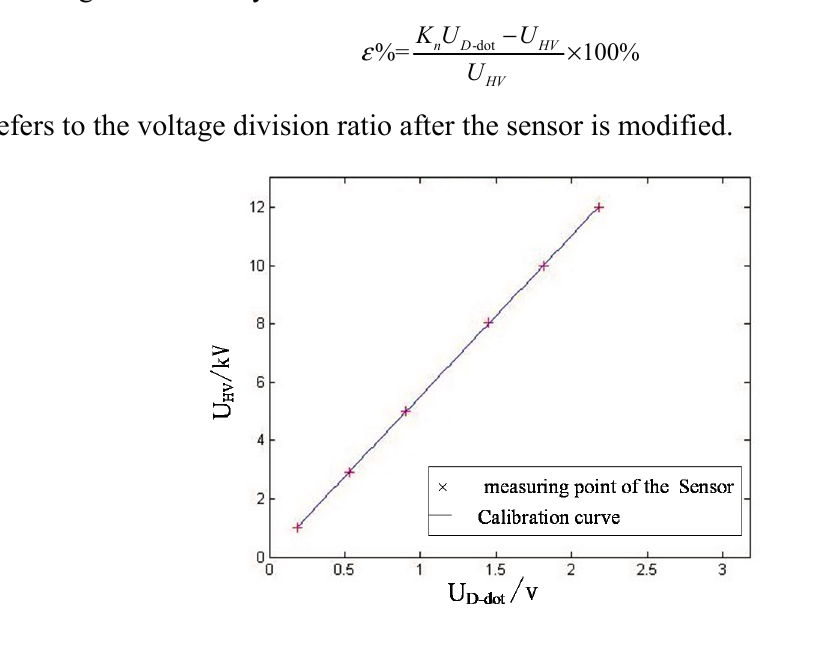
Figure 10. Output voltage calibration curve of mutual sensor and high-voltage probe at different